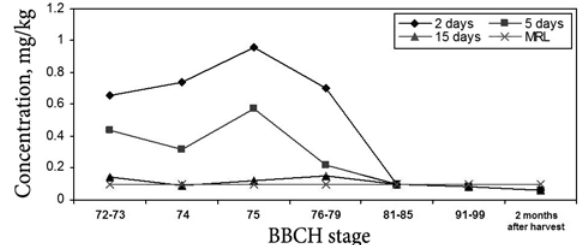
Fig. 12. Degradation of lambda-cyhalothrinin Jonathan apples